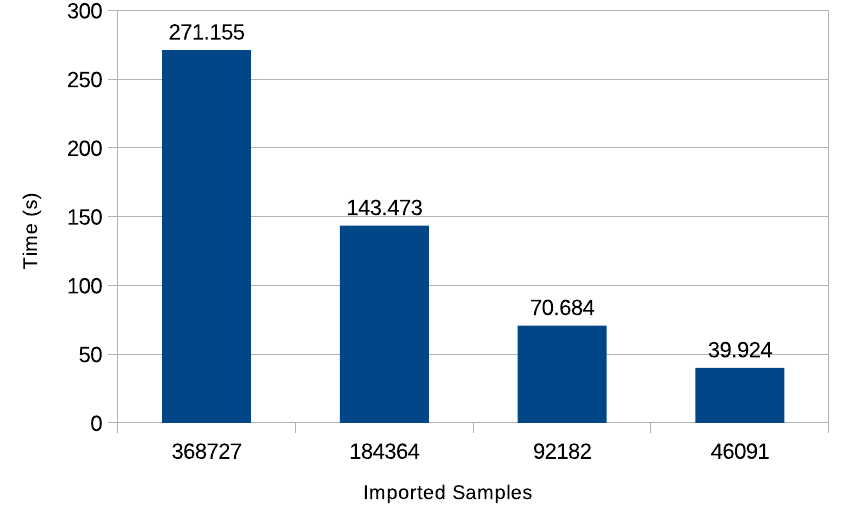
Figure 5. Time required for data import.